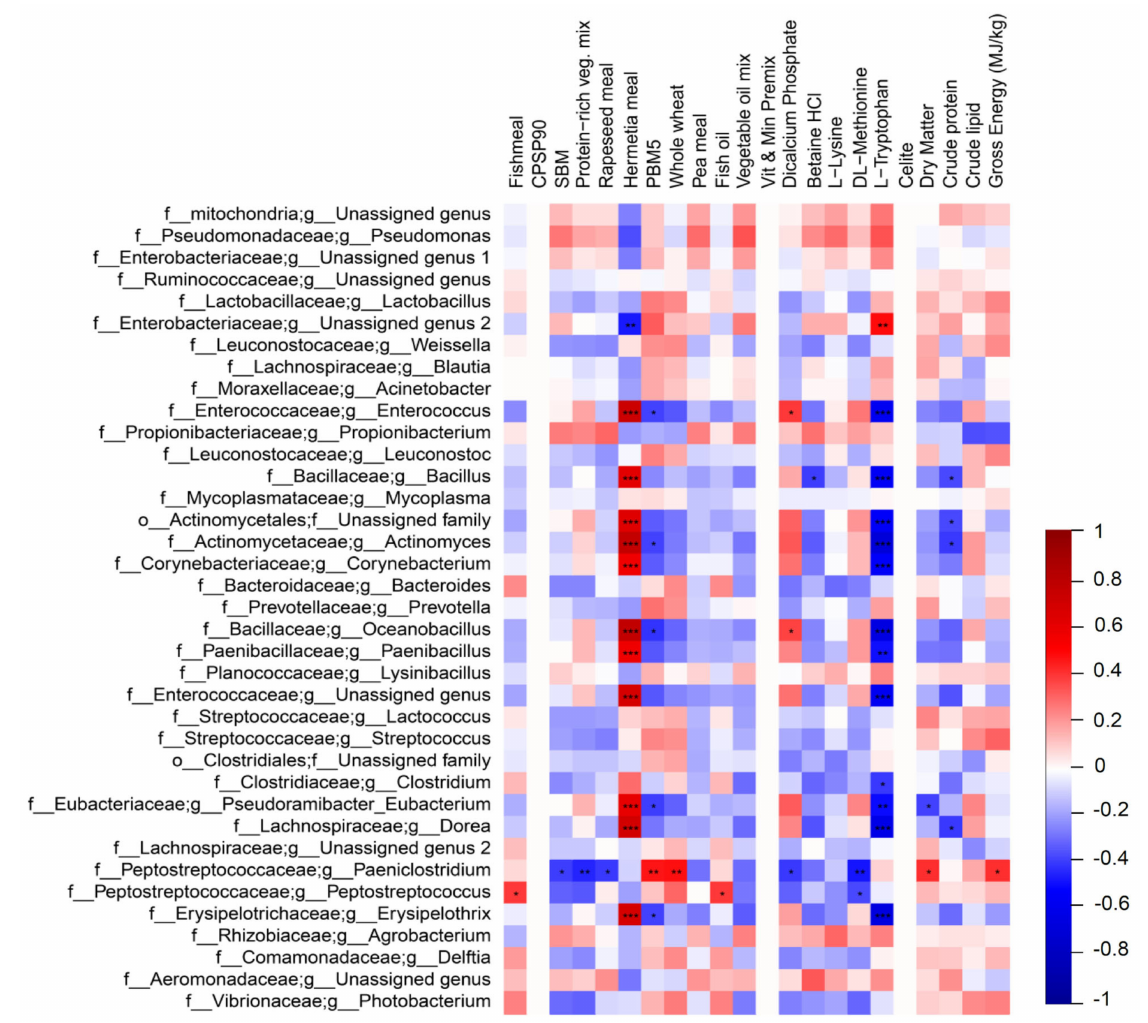
Figure 4. Spearman’s correlation between the relative abundance of gut microbial genera and ingredient composition. A positive correlation is indicated by dark red, a negative correlation by dark blue. Stars indicate statistical significance after FDR correction (* p < 0.05, ** p < 0.01, *** p < 0.001). Families and genera were reported as “Unassigned” when they could not be assigned to any genus (g) or family (f) within the reference database (http://greengenes.lbl.gov, accessed on 13 July 2020), at a percentage sequence homology of 95% or 90% for genus and family,